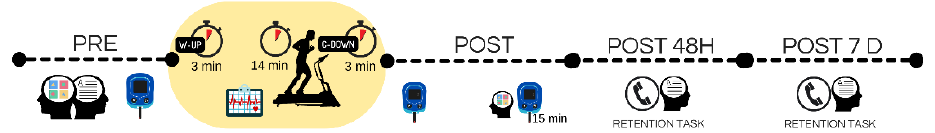
Figure 2. Experimental protocol design.